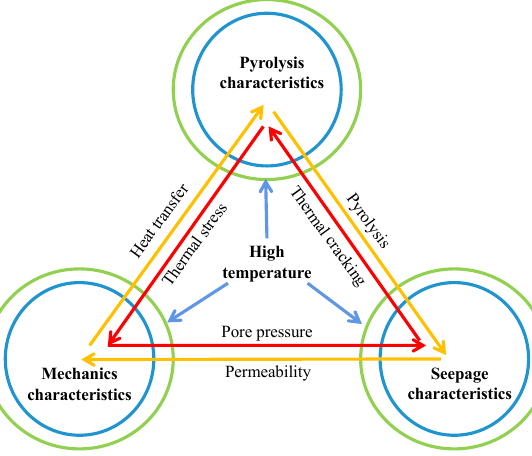
Figure 1. Solid fluid thermochemical multifield coupling process.